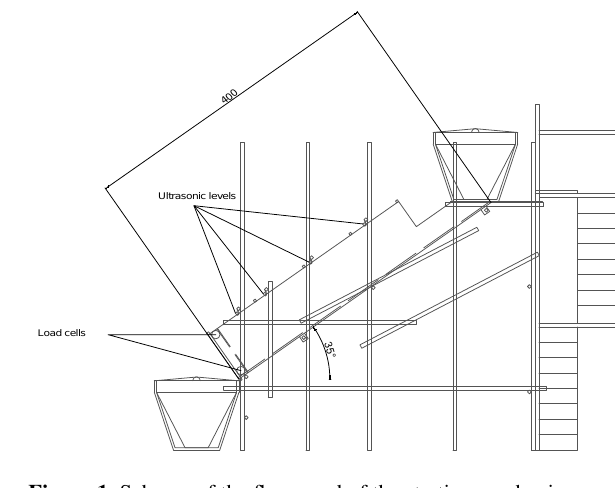
Figure 1. Scheme of the flume and of the starting mechanism.